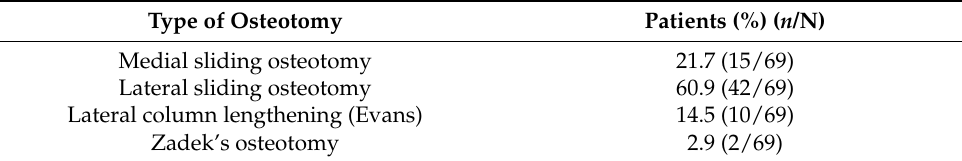
Table 2. Type of